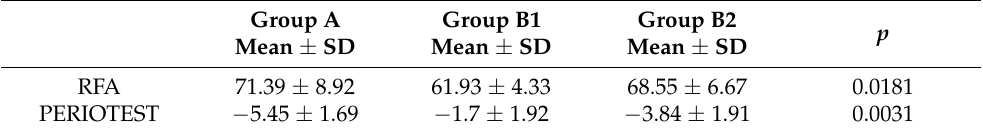
Table 1. Statistical evaluation of the mean stability values of each drilling protocol with standard deviation. Group A